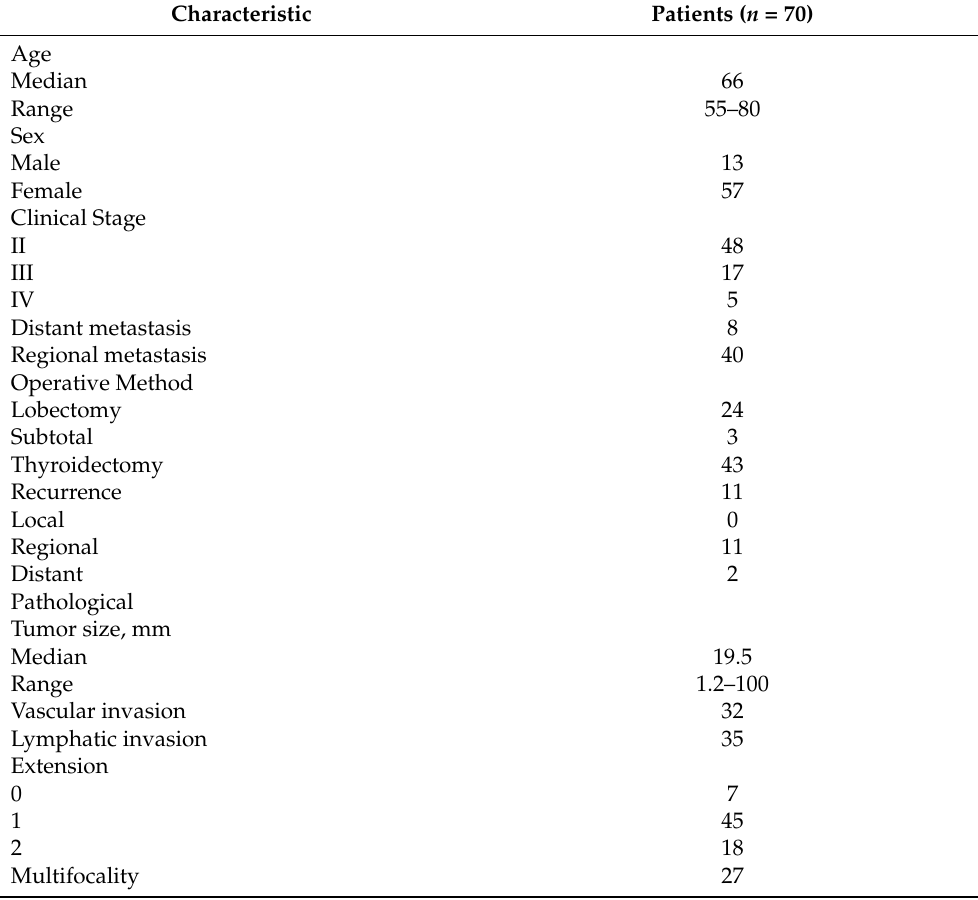
Table 1. The clinicopathological characteristics of the